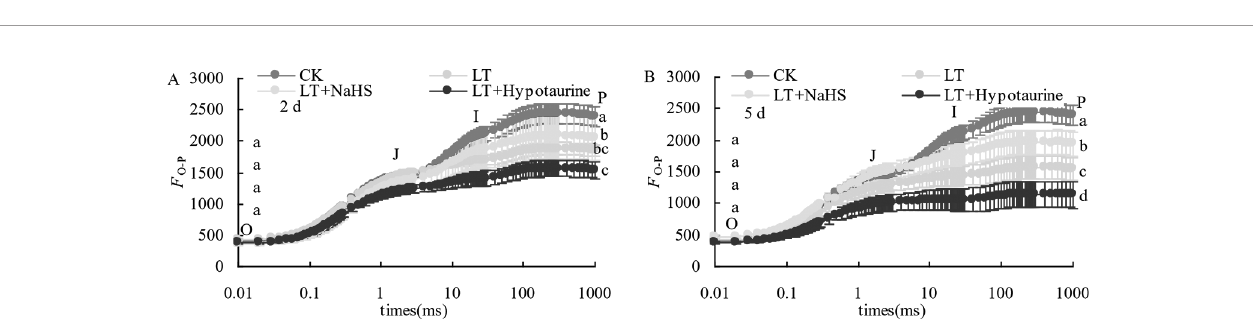
FIGURE 2 | Effects of exogenous NaHS and Hypotaurine on OJIP curves of blueberry leaves under low temperature stress at the 2 nd (A) and 5 th (B) day. The data in the fi gure are from fi ve replicated experiments (n = 5). Different small letters show signi fi cant differences ( P < 0.05). CK: room temperature control at 25°C; LT: low temperature treatment; LT + NaHS: low temperature treatment at 4 – 6°C after spraying 0.5 mmol·L – 1 NaHS; LT + Hypotaurine: low temperature treatment at 4-6°C after spraying leaves with 200 m mol·L – 1 hypotaurine.